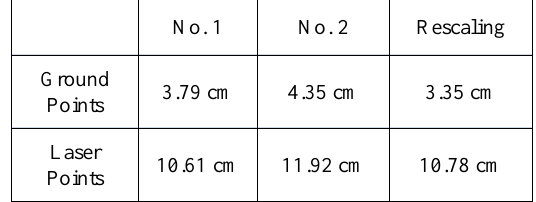
Table 4: The average distance between the land surveyor’s points and the 3D model points